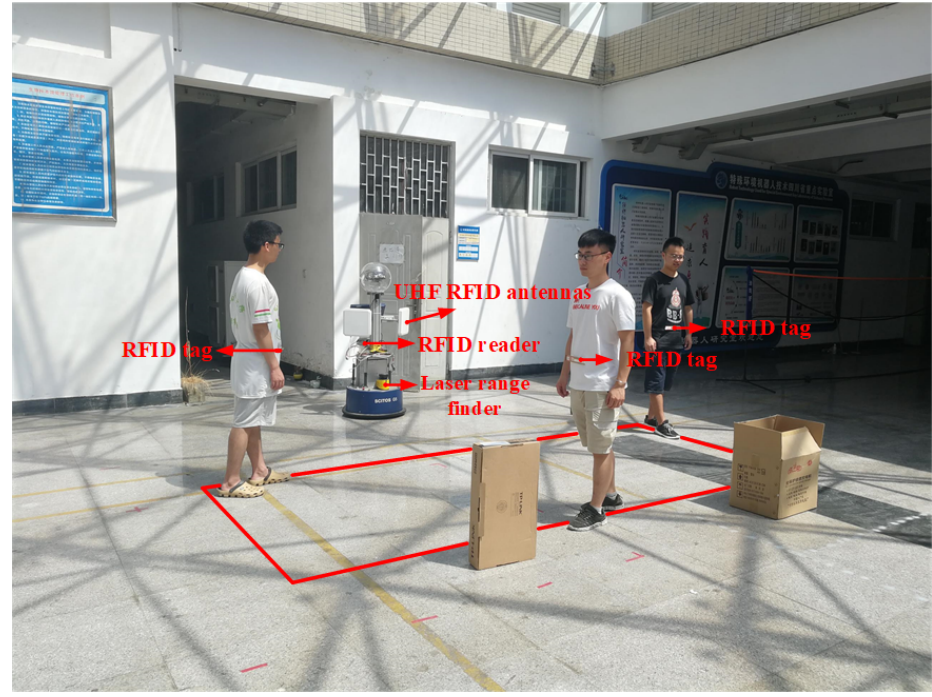
Figure 3. Experimental